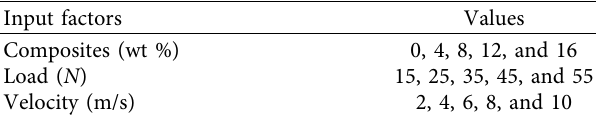
Table 2: Pin-on-disc wears testing input factors.